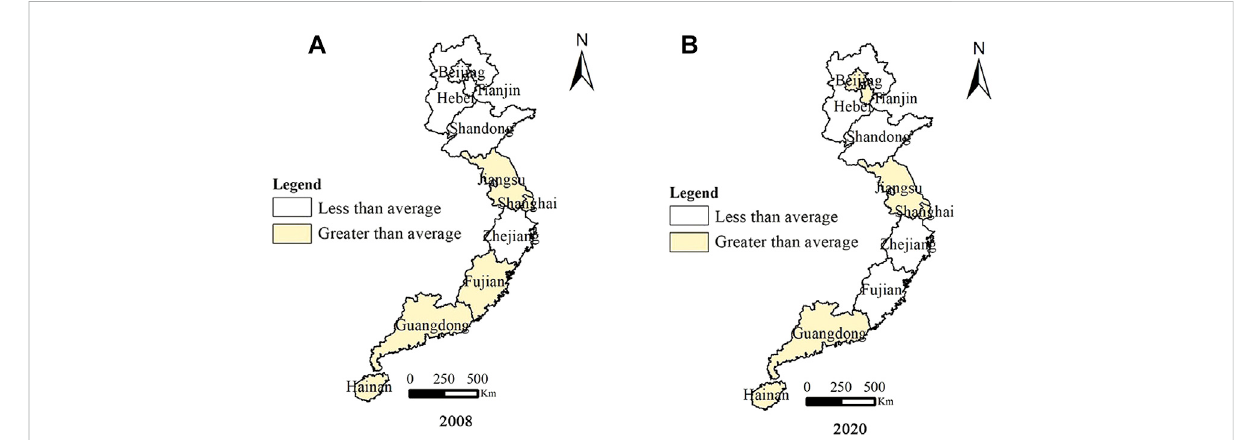
FIGURE 4 Spatial differentiation of industrial land optimization dimension (2008 and 2020).